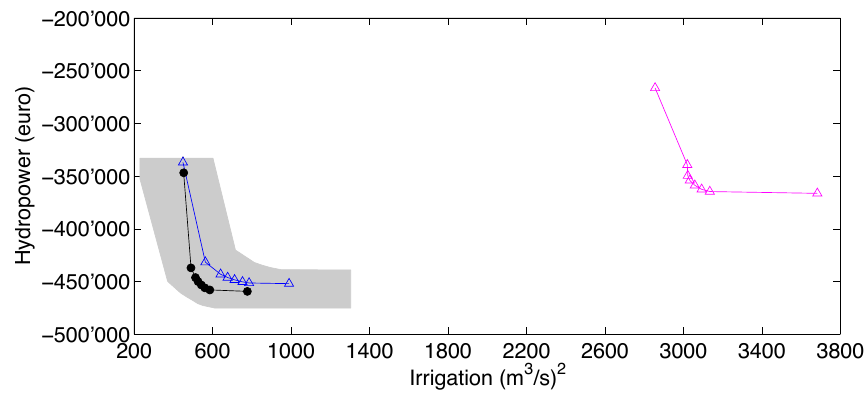
Fig. 7. IPF under historical inflow 1967–1980 (black dots), backcast inflow scenario 1961–1990 by RACMO RCM (blue triangles) and forecast inflow scenario 2071–2100 by RACMO RCM (magenta triangles). The grey region represents the natural variability of backcast climate scenario obtained as the envelope of the IPFs over a sliding window of 14 years reported in Fig.